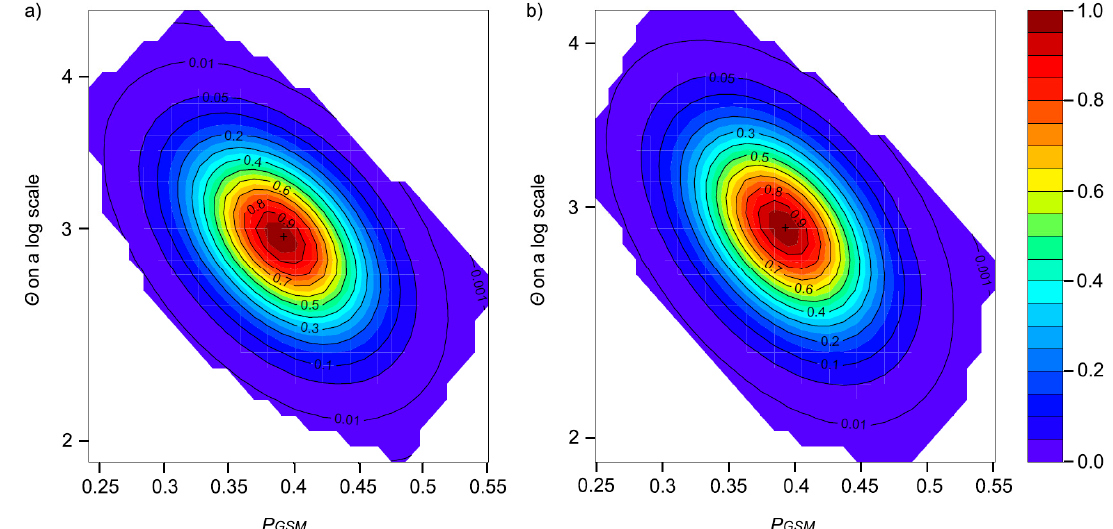
Figure 5. Two-dimensional profile likelihood regions of the parameter for the geometric distribution of mutation sizes (pGSM) and Θ from M igraine ’s ‘OnePop’ model for: ( a ) APNR and ( b ) APNR + KNP. pGSM and Θ in log scale are in the x and y axes, respectively.